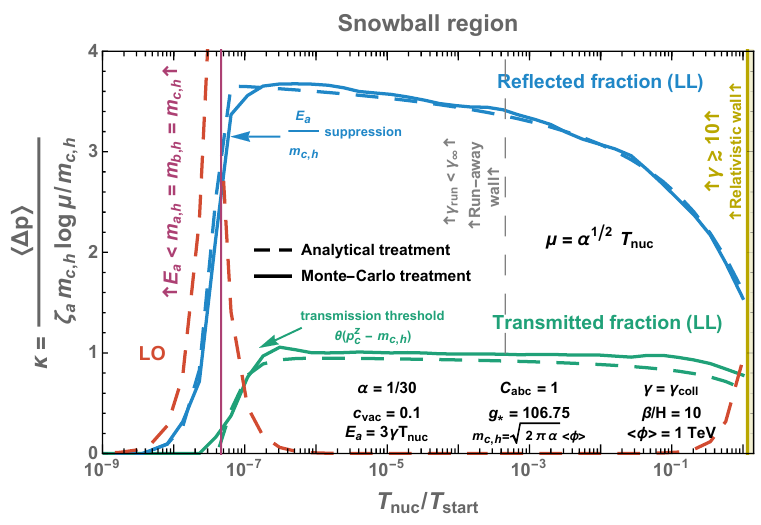
Figure 17 . Comparison between analytical treatment in dashed lines and MC treatment in solid lines. The blue and green lines show the exchanged momentum induced by radiated bosons re- summed at all leading-log orders, either transmitted (green) or reflected (blue) by the wall boundary. The red dashed line shows the LO contribution assuming no splitting radiation. In the run-away regime, we have E a /m c,h ∼ ( M pl / h φ i )( T nuc /T start ) 2 , see eq. (3.55) and eq. (6.11). Therefore,